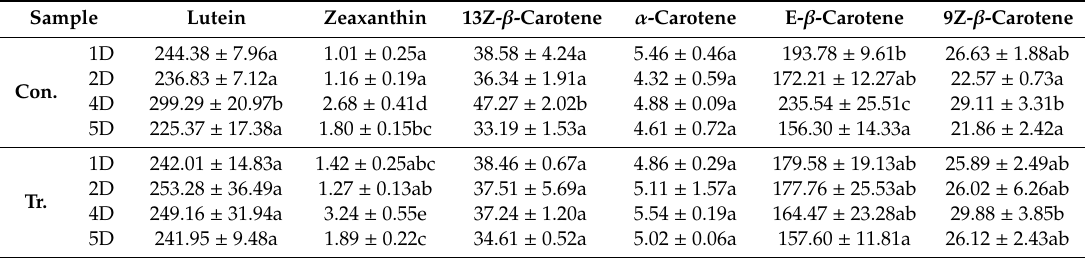
Table 3. The contents of carotenoid in tartary buckwheat in response to salt stress ( µ g / g dry weight). Sample